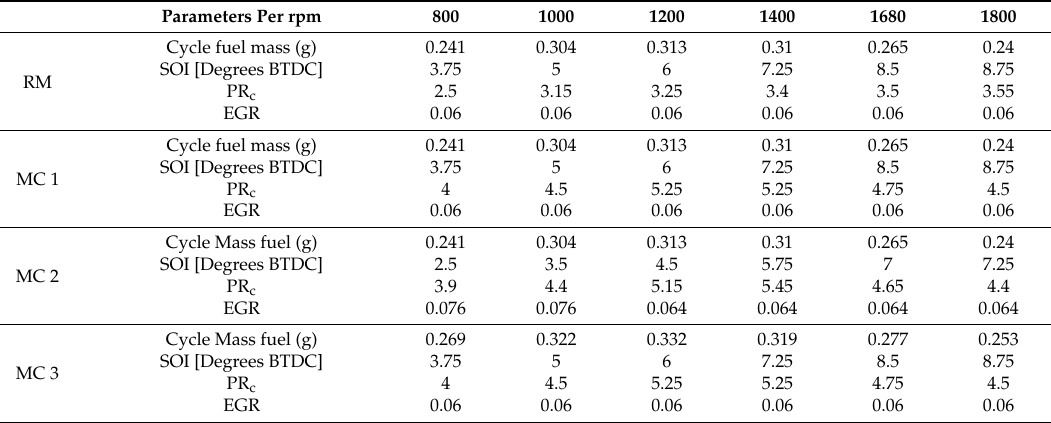
Table 4. Engine operating parameters for all